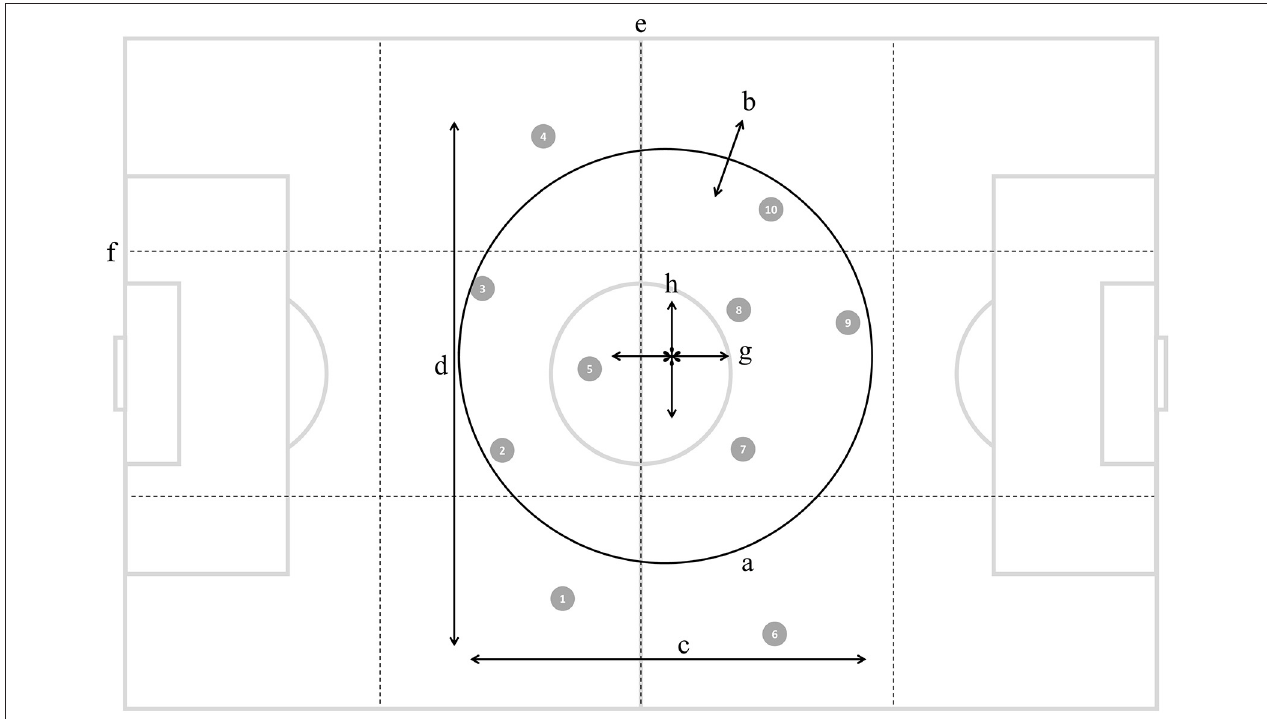
FIGURE 1 | Illustration of ten outfield players (numbered gray circles) and the eight positioning-derived variables: (a) stretch index, (b) speed of dispersion, (c) length, (d) width, (e) sectors, (f) corridors, (g) longitudinal speed of team center, and (h) latitudinal speed of team center.